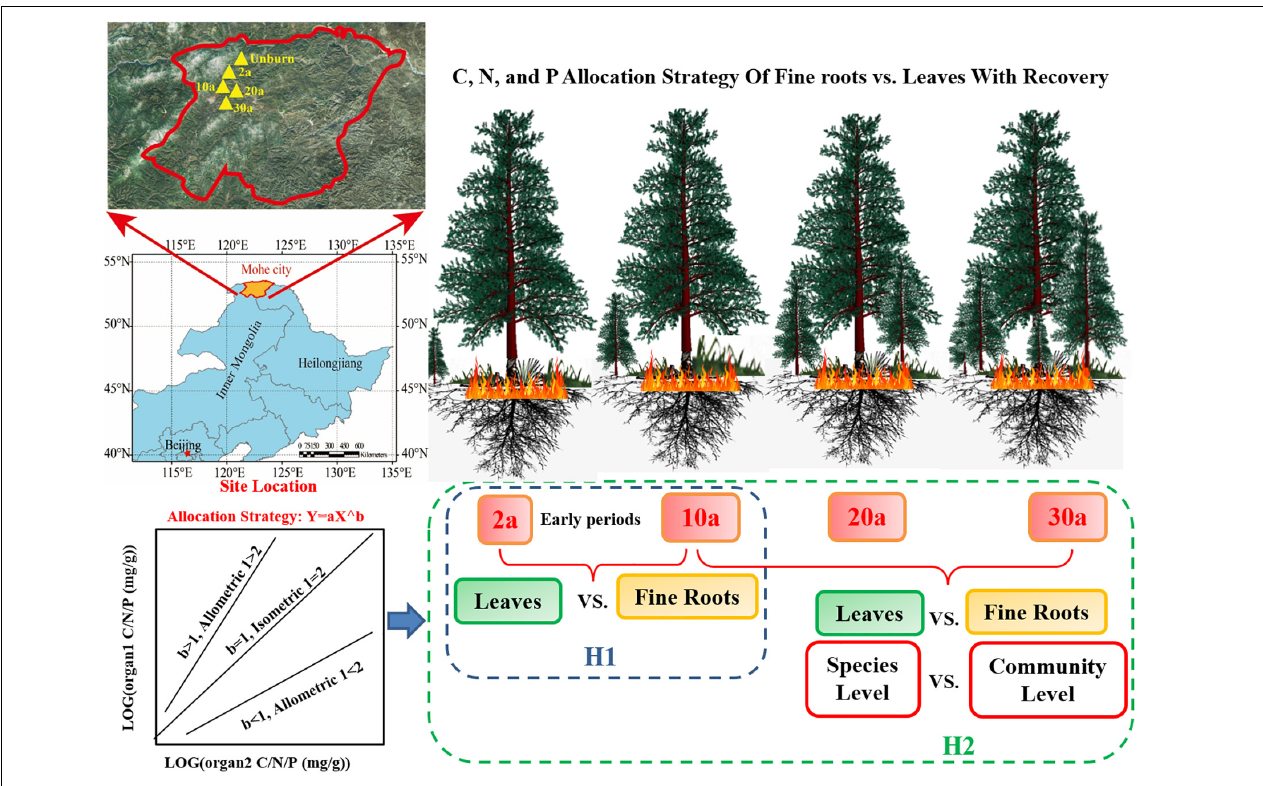
FIGURE 1 | Theoretical framework for the allocation strategies of carbon (C), nitrogen (N), and phosphorus (P) with recovery after a wildfire. The plants C, N, and P stoichiometries allocation would be substantially changed in the early periods during recovery (H1), and the organ stoichiometry allocation strategies may be different in the species level and the community level (H2). 2a, 10a, 20a, and 30a are at year 2, year 10, year 20, and year 30 after recovery, respectively. UB, unburned.